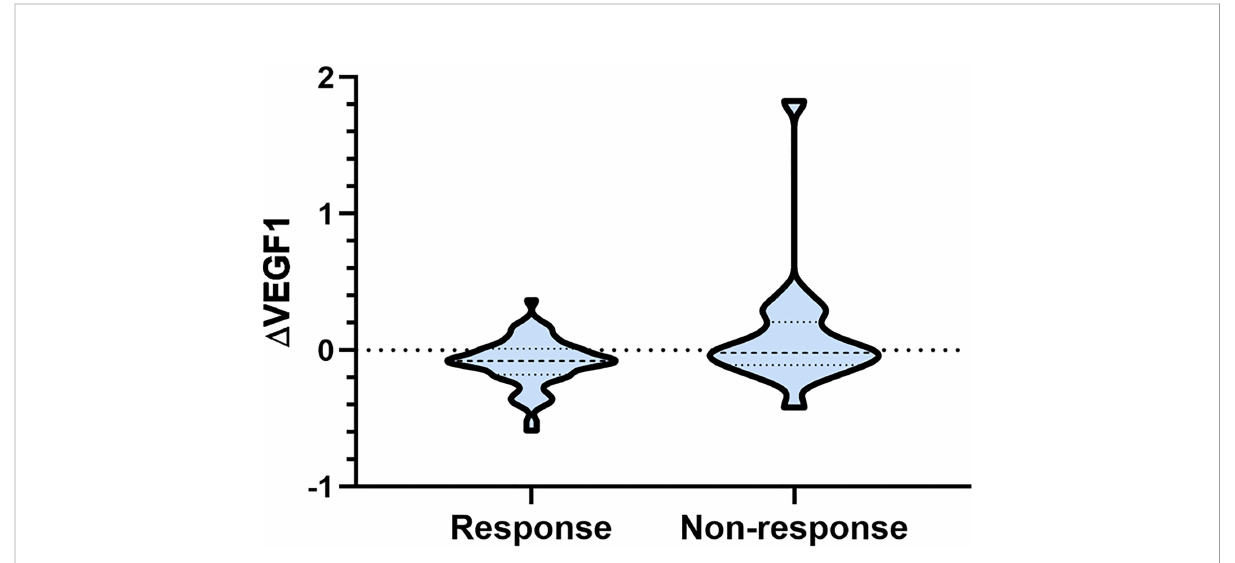
FIGURE 1 Comparison of serum Δ VEGF1 in different response groups after